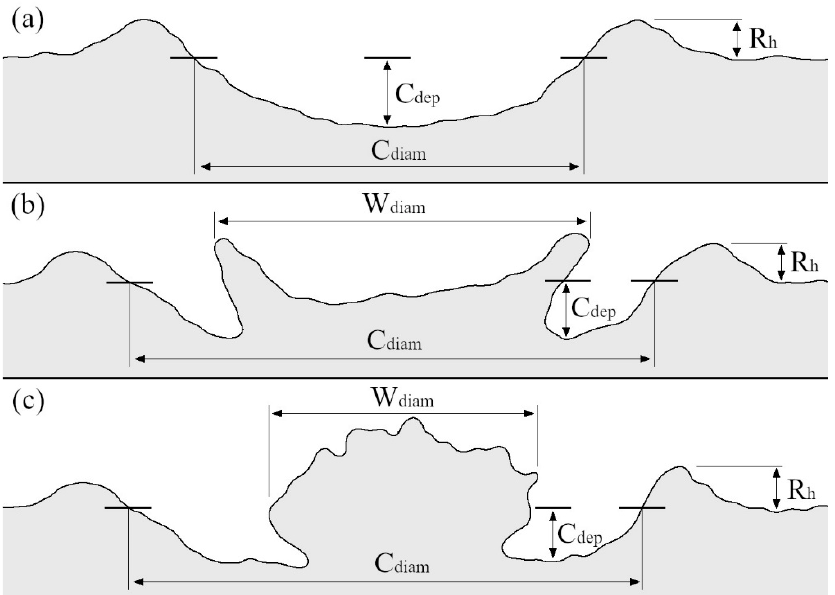
Figure 1. Illustrative diagrams showing examples of crater cross sections (( a )–simple crater; ( b )–crater with spread liquid-grain residues; ( c )–crater with aggregate liquid-grain residues), with example quantities used to characterise their morphology (C dep –depth of the crater; C diam –diameter of the crater; R h –height of the rim; W diam –diameter of the moistened volume of the deposit material). Craters, characterized by the simplest structure, are formed by a small cavity (with a shape simplistically resembling a hemisphere), which may be surrounded by displaced material forming a rim (Figure 1a). Such deformations are most often observed in moist deposits, which relates their morphology to the interaction of the drops with the water in the pores of the sample. The regularity and depth of the cavity, as well as the height of the rim, depend on the parameters of the deposit, e.g., moisture content, compaction, slope, particle size distribution and the energy of the drops.